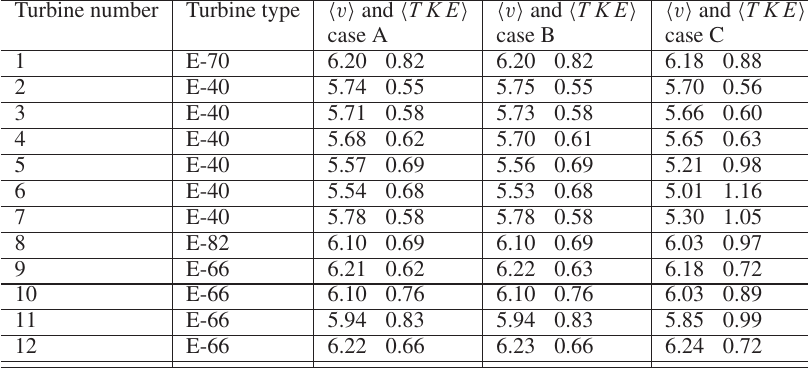
Table 2. Comparison of the mean wind speed (cid:7) v (cid:8) (ms − 1 ) and mean turbulent kinetic energy (cid:7) T KE (cid:8) (m 2 s − 2 ) at hub height for each wind turbine and wind direction for case A, B and C.